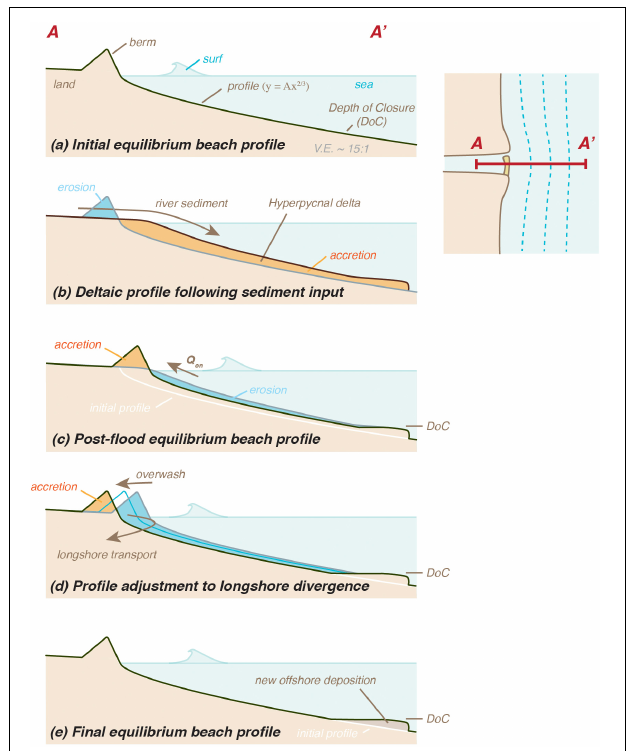
FIGURE 11 | (a–e) Generalized morphodynamic model for river mouths with dispersive or hyperpycal deltas during and after sediment input from the river based on observations from the Santa Clara River of California. Consistent with Figure 10 , the vertical exacerbation (V.E.) is approximately 15. Rules-Based Geometric